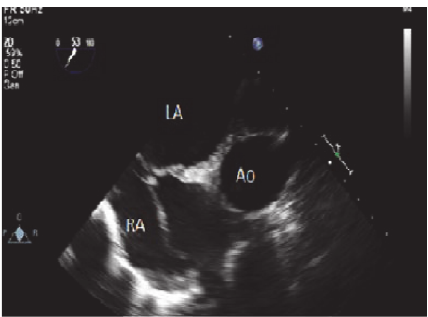
Figure 1: Thrombus formation in right atrium after the procedure, transesophageal echocardiography image of thrombus (Ao: Aorta, LA: Left Atrium, and RA: Right